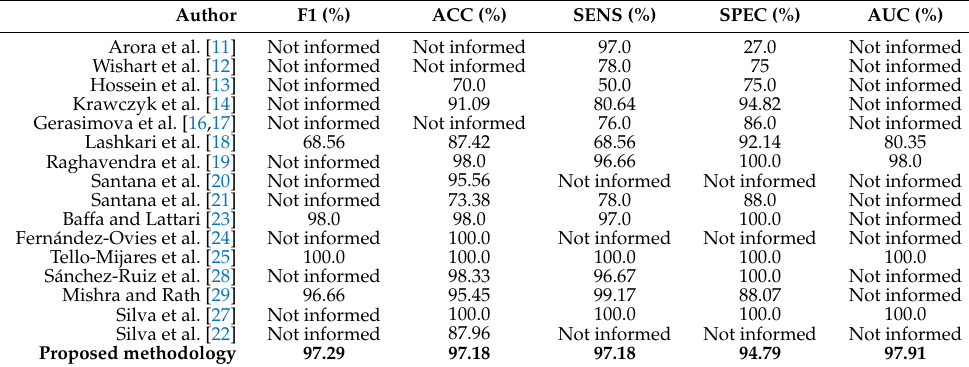
Table 14. Proposed method comparison with related